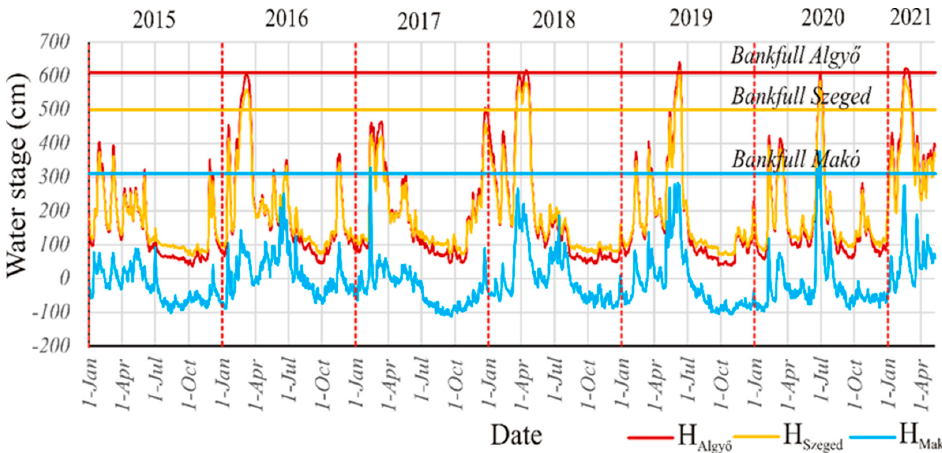
Figure 2. Daily water stages and bankfull levels at the studied gauging stations of the Tisza (Algy ő and Szeged) and Maros Rivers (Makó) throughout the studied period (January 2015 ‐ May 2021).